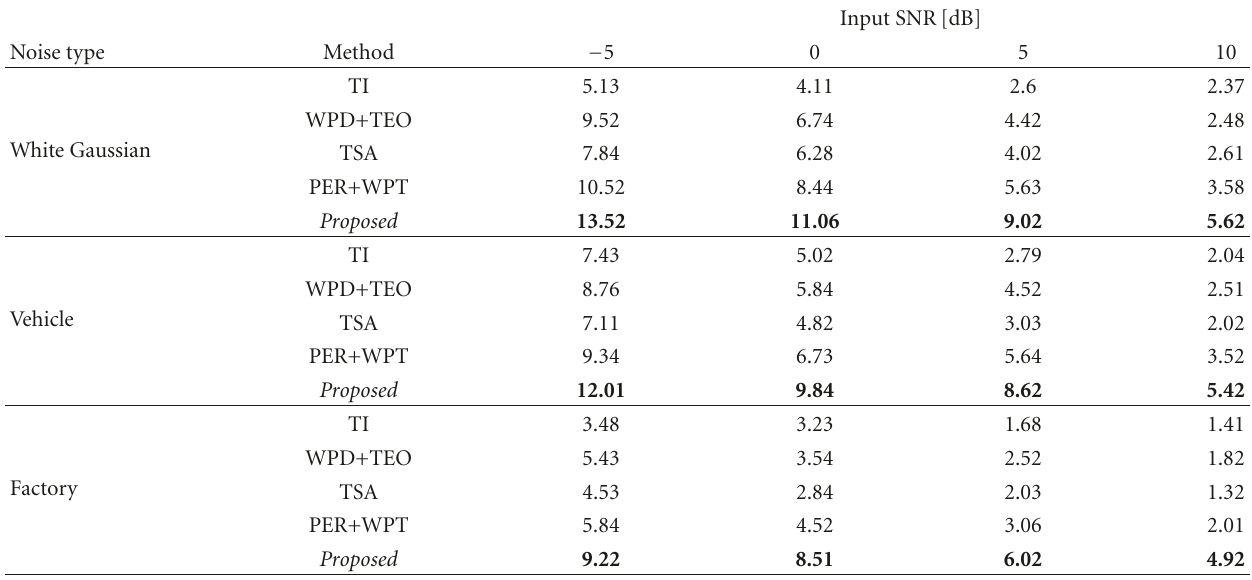
Table 1: The objective evaluation using SegSNR improvement.